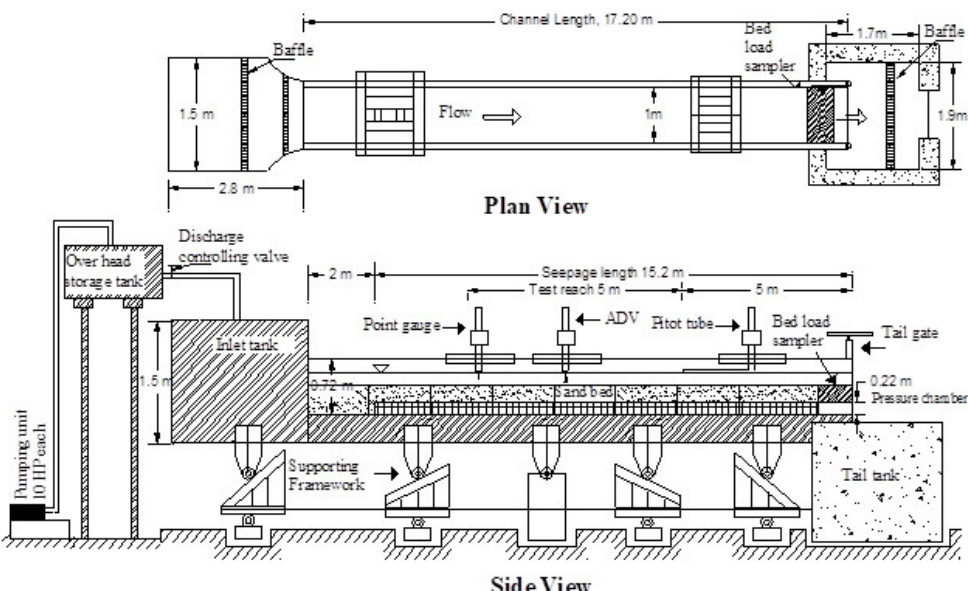
Figure 1. Schematic diagram of the tilting channel used in this study (not to scale).